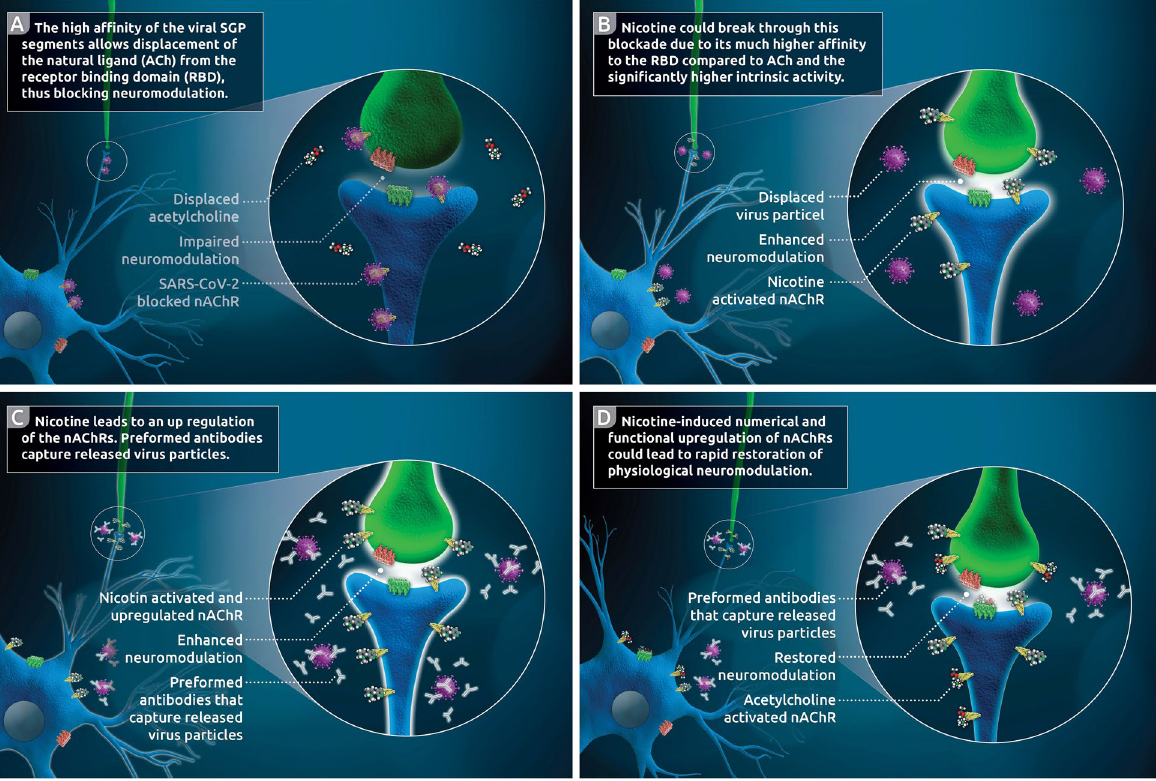
Fig. 2 (nAChR competition of ACh, SARS-CoV-2 and nicotine): Membrane-bound neuro-modulatory nAChRs get attached to SARS-CoV-2 viruses in a non-intrinsic fashion, displacing the natural ligand (ACh) and thereby substantially compromising neuro-modulatory cholinergic signaling ( A ). Due to the high affinity of nicotine to nAChRs, the virus is extruded from the attachment to nAChRs by nicotine, thus neutralizing the blockade of cholinergic neuro-modulatory signal transmission ( B ). Since long-haul COVID patients have pre-formed SARS-CoV-2 specific antibodies, the released viruses are captured by these antibodies, thereby preventing active reinfection with SARS-CoV-2 ( C ). Both the high intrinsic activity of nicotine at nAChR and the nicotinic up-regulation of nAChRs lead to the re-establishment of ACh-borne neuromodulation ( D